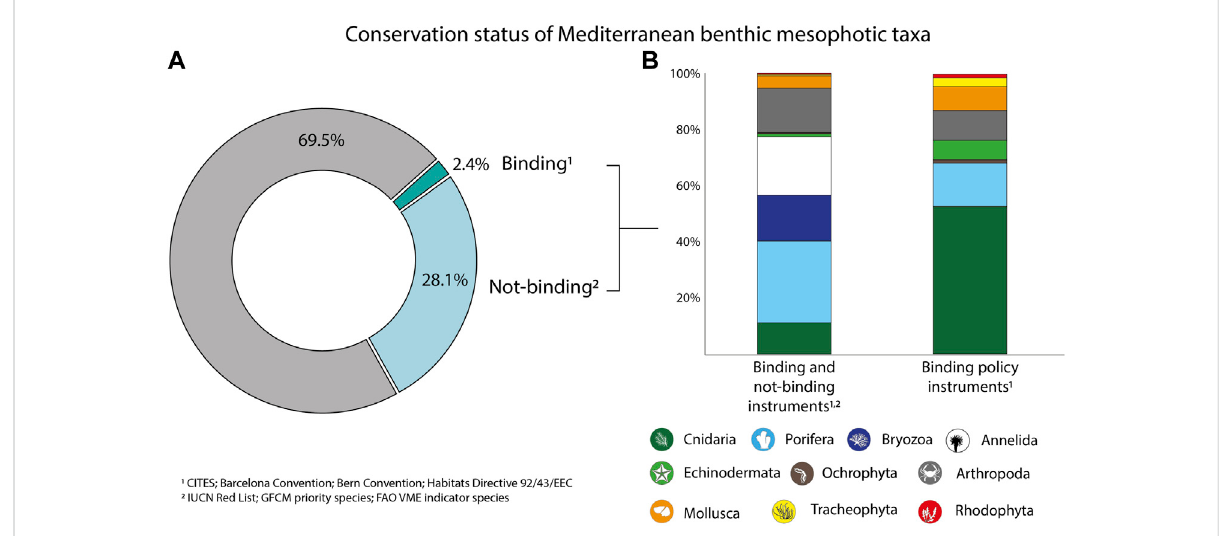
FIGURE 3 Portion of benthic mesophotic taxa included in the International Legal Framework, considering both binding and not-binding instruments (A) , and percentage contribution of the identi fi ed Phyla to taxa listed under legal instruments (B) .